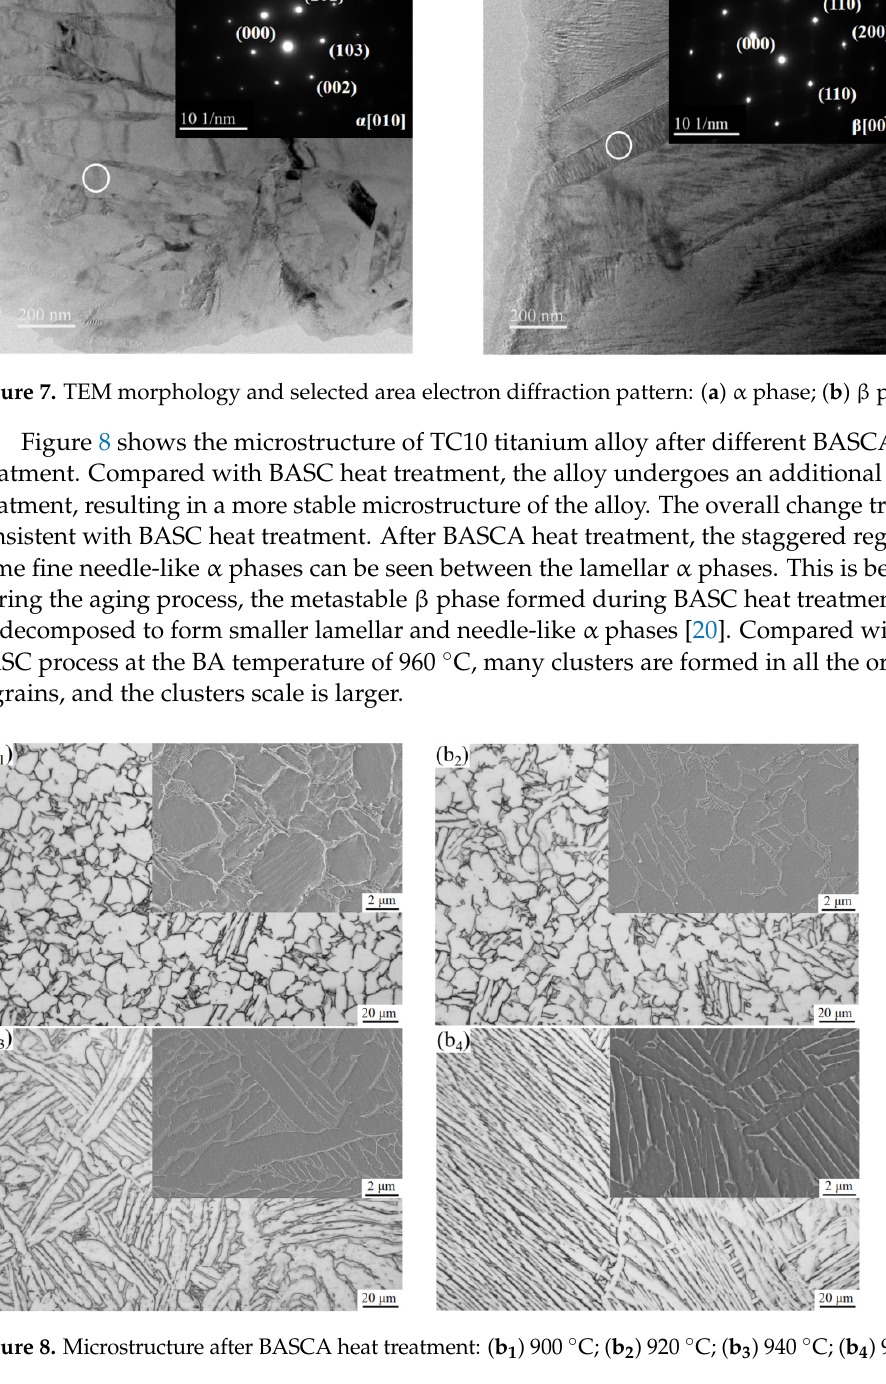
6 of 12 Figure 6. XRD diffraction patterns after BASC heat treatment: ( a ) Scanning angle (20~80°); ( b ) Scan- ning angle (39~43°); ( c ) Scanning angle (51~65°). The higher the heating temperature is, the more sufficient the driving force of mar-